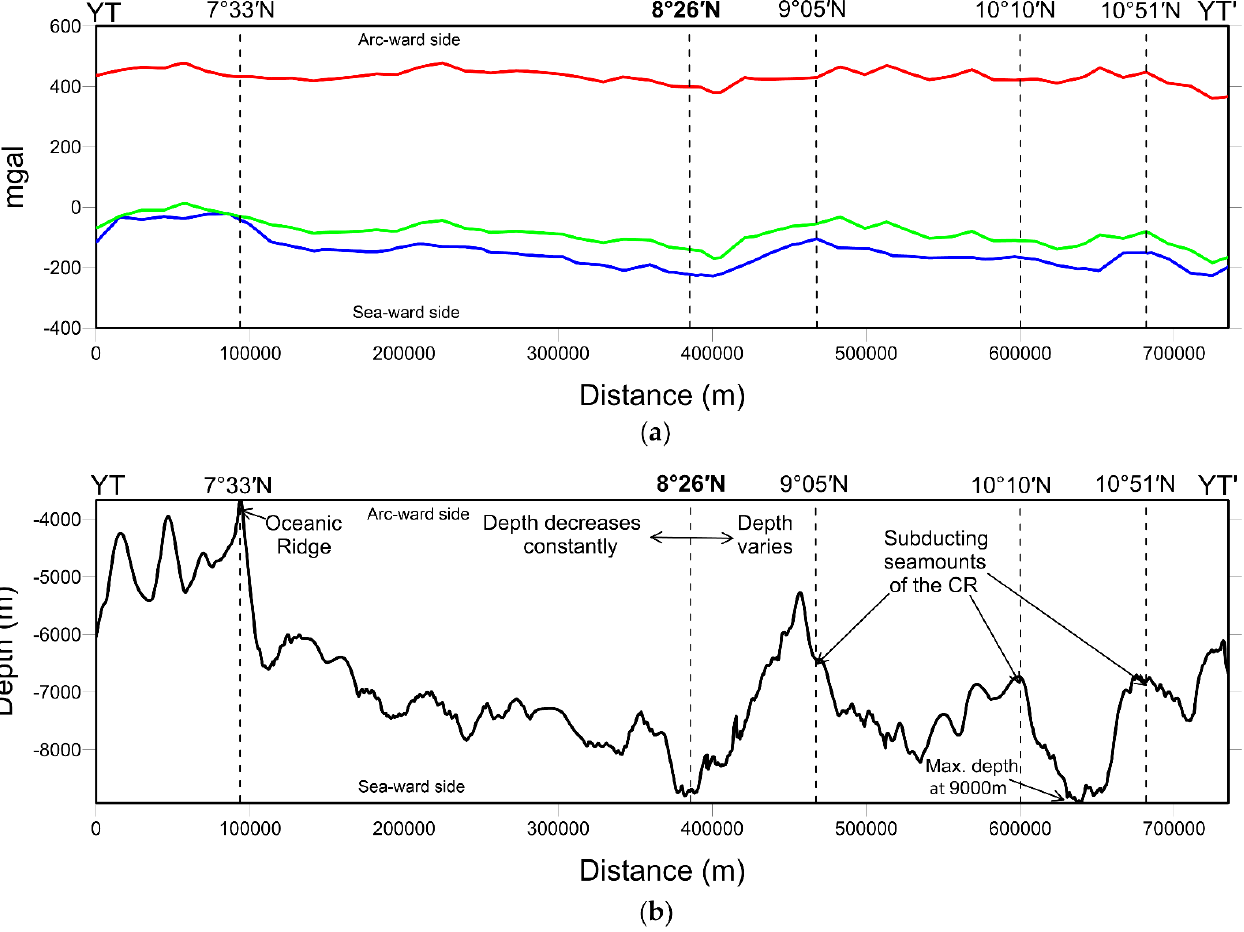
Figure 4. The impact of CR subduction on the comprehensive geophysical characteristics along the Yap Trench axis. ( a ) Gravity anomaly profiles YTYT’ (Red = Bouguer gravity anomaly, Blue = free-air gravity anomaly, Green = isostatic gravity anomaly); ( b ) Bathymetric profile YTYT’. The subducting seamounts of the CR elevate the trench axis by around 2000–4000 m from the maximum depth north of 8°26 ′ N. The profiles are extracted from the line segment YTYT’ along the Yap Trench axis as shown in Figure 1.